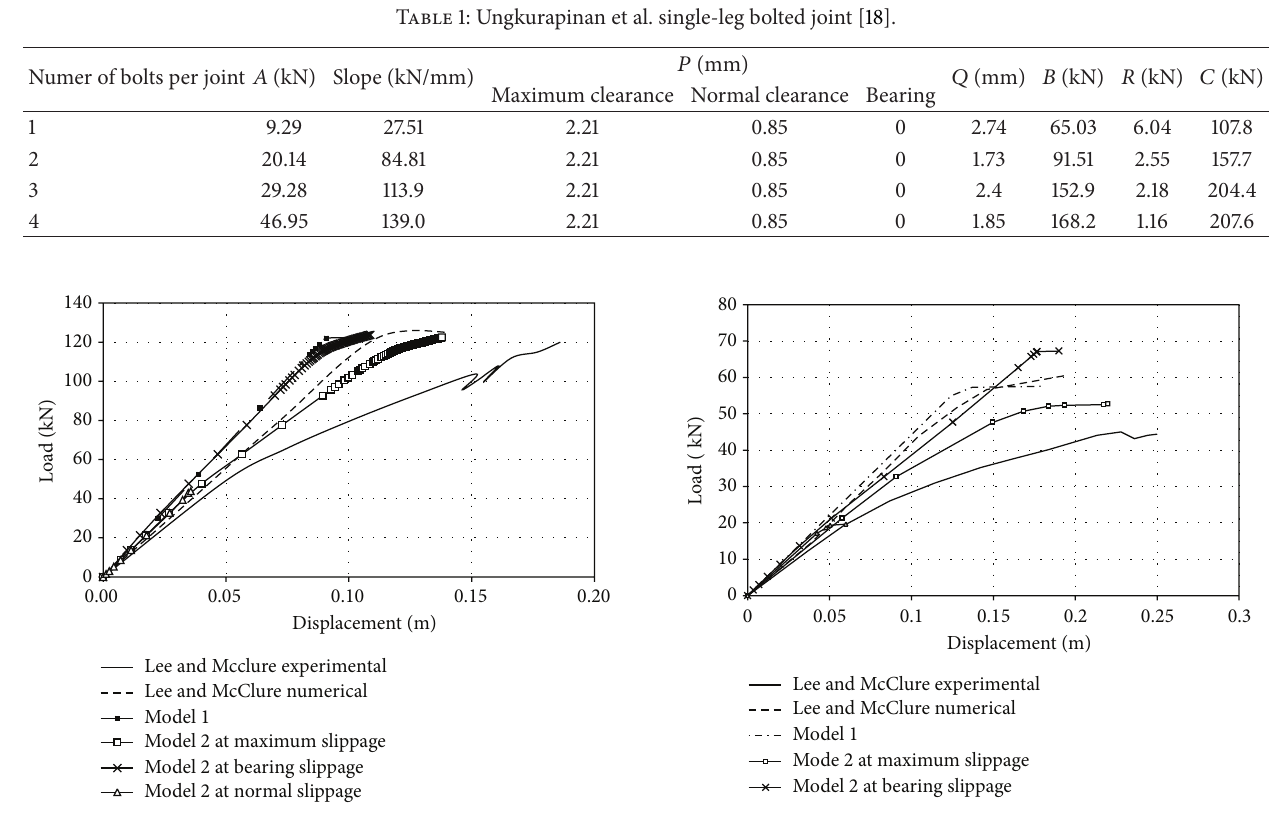
Figure 13: Load-displacement curves in the bending case. Figure 14: Load-displacement curves in the flexural-torsion